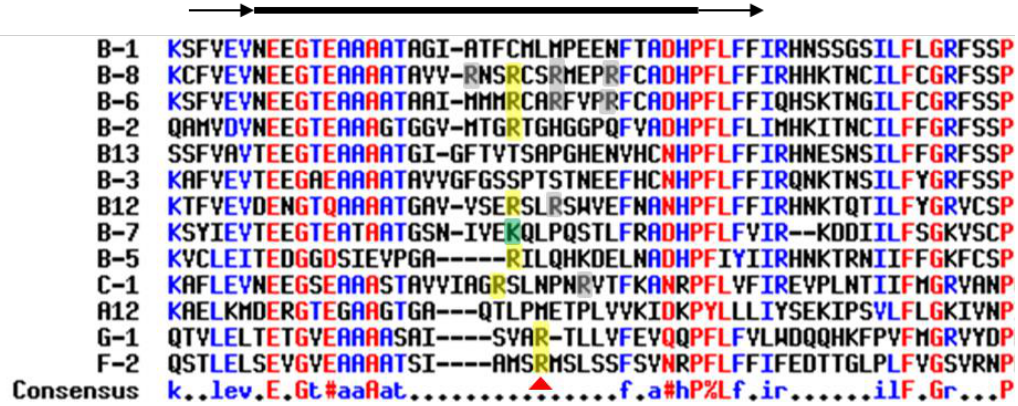
Figure 3. Multiple alignment of 13 serpin reactive center loops (RCL). Multiple alignment (Multalin) of the full primary sequence of 13 serpins was performed (available at http://multalin.toulouse.inra.fr/multalin/). At the top of the figure, RCL region is delimited by a thick black line and surrounded by beta-sheets (black arrows). Amino acids in red are conserved in all sequences and those in blue are partially conserved. Uniprot accession numbers of the 13 human serpins used are: A12 (Q8IW75), B1 (P30740), B2 (P05120), B3 (P29508), B5 (P36952), B6 (P35237), B7 (O75635), B8 (P50452), B12 (Q96P63), B13 (Q9UIV8), C1 (P01008), G1 (P05155) and F2 (P8697). The positively charged arginine (R) at position P1 of the RCL is indicated by a red triangle for serpin F2 and is highlighted in yellow for the others. Other arginines of the RCL are highlighted in grey, and lysine (K) in green.